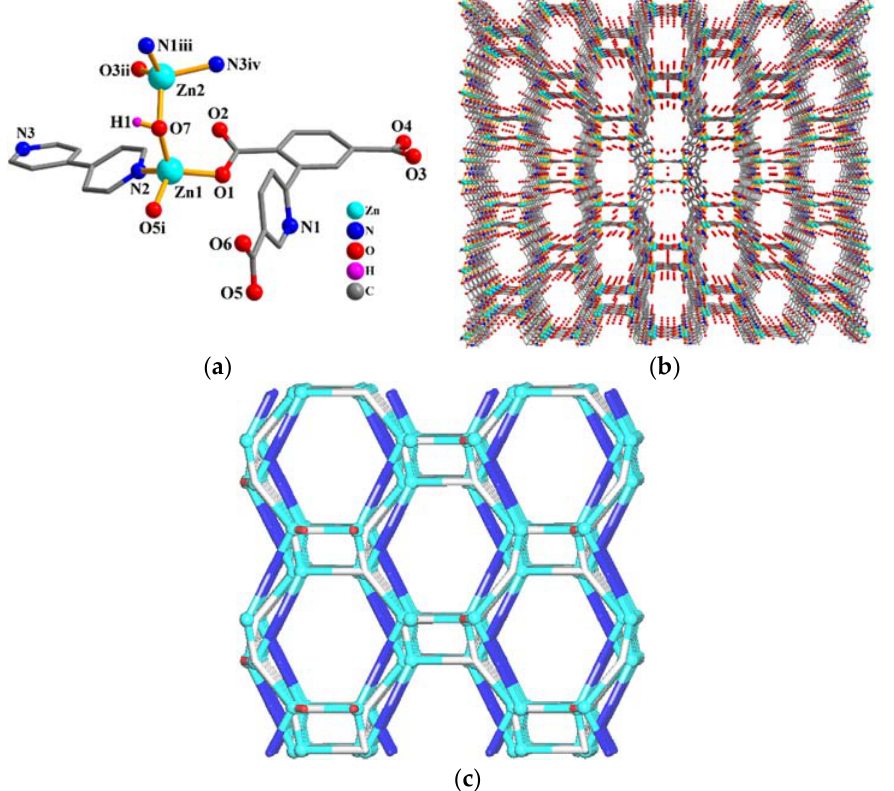
Figure 2. Structural fragments of 2 . ( a ) Coordination environment around the Zn(II) atoms; H atoms are omitted for clarity except one of OH − group. Symmetry code: i = − x , − y , − z ; ii = − x + 1/2, y + 1/2, − z + 1/2; iii = x , − y , z + 1/2; iv = − x + 1/2, y − 1/2, − z + 1/2. ( b ) 3D metal ‐ organic framework seen along the c axis. ( c ) Topological representation of an underlying binodal 4,4 ‐ connected framework with the isx topology; view along the c axis. Color codes: 4 ‐ connected Zn centers (cyan balls), centroids of 4 ‐ connected cpta 3 − blocks (gray), centroids of 2 ‐ connected μ‐ OH − (red) and μ‐ 4,4 ′‐ bipy (blue) linkers.